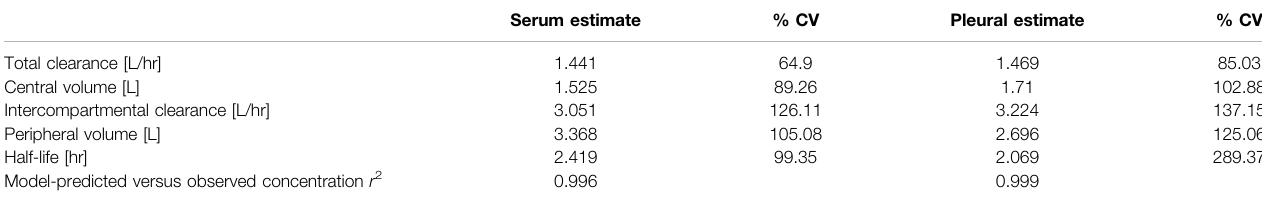
TABLE4| ADAPTpharmacokinetic-modelgeneratedparametersusingconcentrationsprovidedbyCole(ColeandPung,1977).InthestudybyCole(ColeandPung,1977) ,cefazolin 1 g was administered intravenously. After 60 min of drug administration in nine patients, the reported C max (mean ± Standard Deviation) was 65.65 + 29.65 mg/L in the serum and 12.45 + 5.75 mg/L in the pleural fl uid (Cole and Pung,